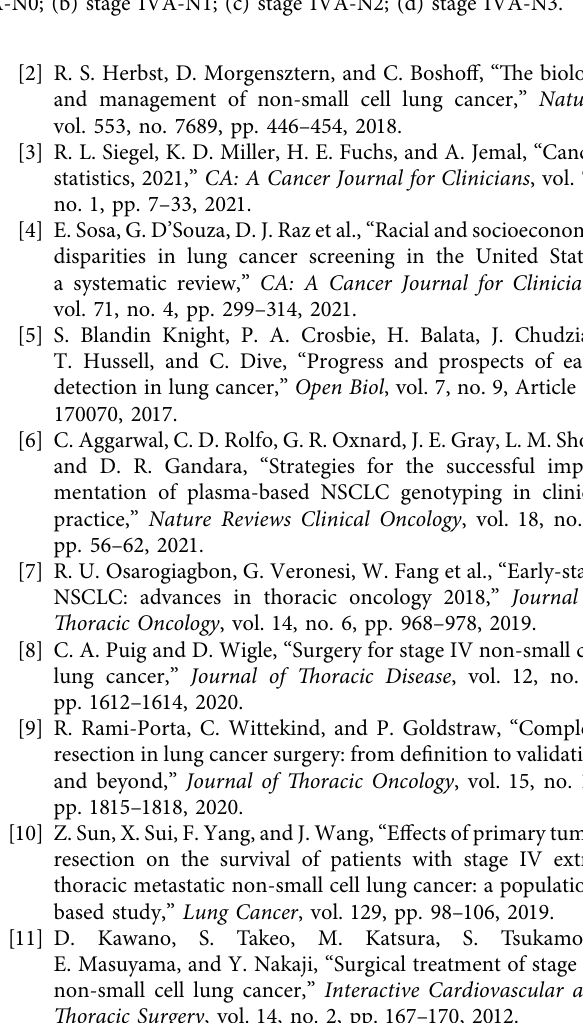
Supplemental Figure 1: SMD plot of each variable after processing using diferent methods. IPTW: the inverse probability of treatment weighting; SMRW: the standardized mortality ratio weighting; PA: pairwise algorithmic; OW: overlap weight. ( Supplementary Materials )